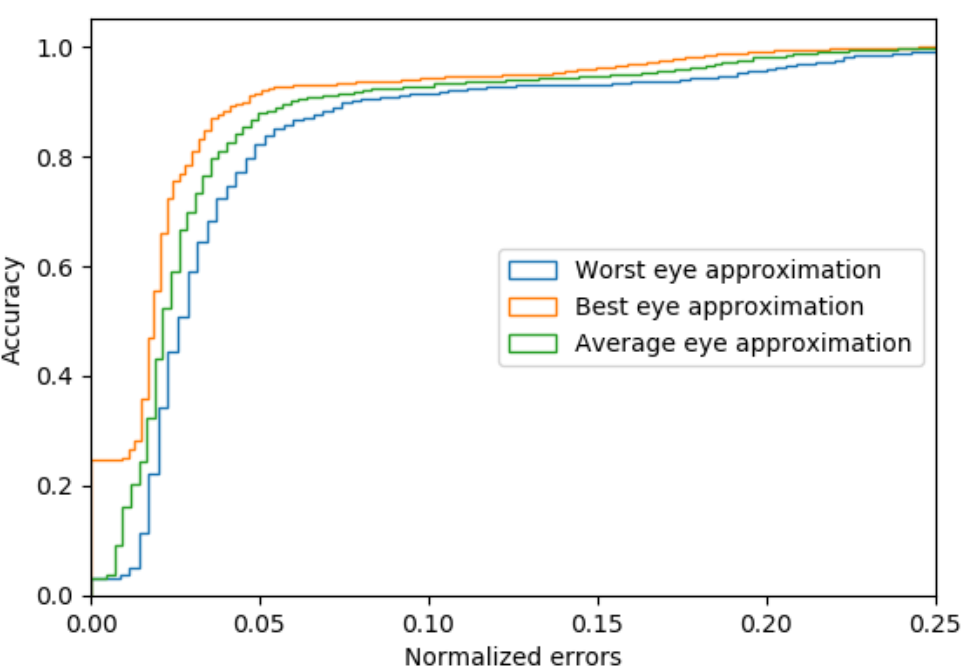
Figure 7. Cumulative error distribution on the BIO-ID face